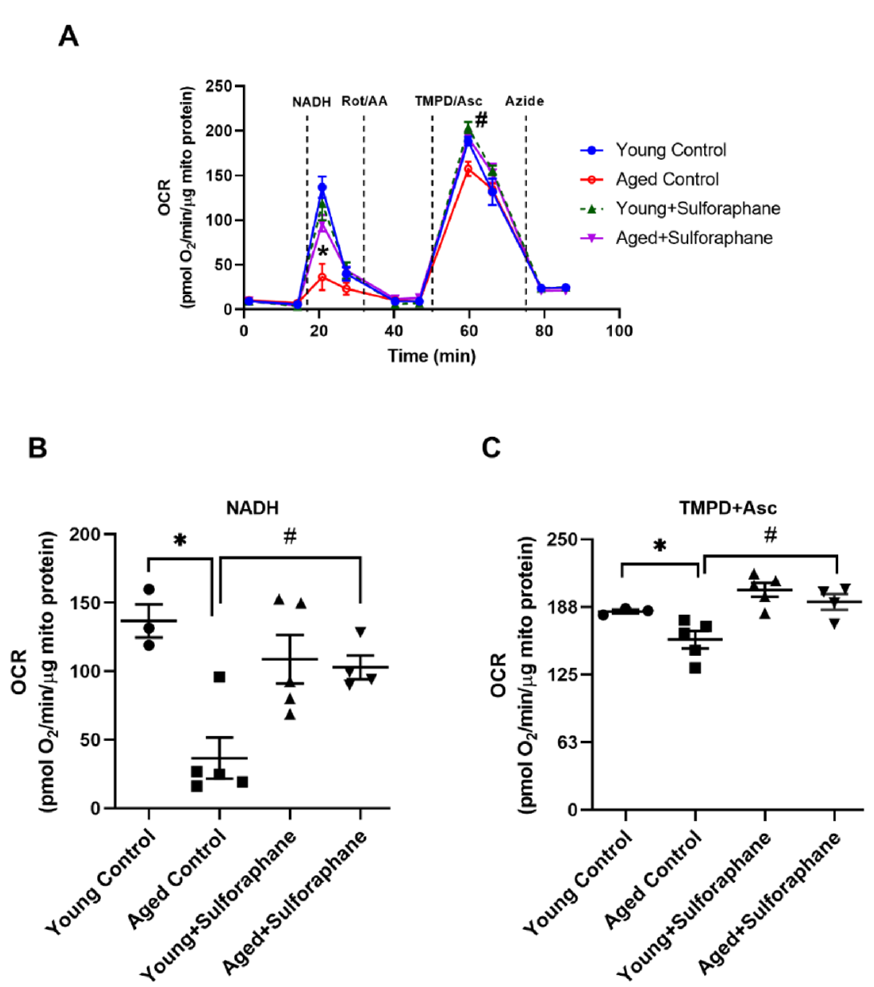
Figure 2. Sulforaphane improves age-mediated decrease in mitochondrial respiration. ( A ) Representative graph showing oxygen consumption rate by renal cortical mitochondria measured upon addition of electron donors specific for complex I (NADH), complex IV (TMPD+ascorbate), and inhibitors for complex I (Rot), complex III (AA), and complex IV (Azide). The vertical lines indicate the timepoint of addition of respective electron donors or inhibitors. ( B , C ) Bar graphs showing oxygen consumption rate measured using NADH and TMPD+ascorbate as electron donors, respectively, in the renal cortical mitochondria of young control (young F344 rats kept on tap water); aged control (aged F344 rats kept on tap water); young+sulforaphane (sulforaphane, 15 mg/kg body wt/day in drinking water); aged+sulforaphane. Results are presented as mean ± SEM, n = 3–5 rats. * p < 0.05 significantly different from young control rats; # p < 0.05 significantly different from aged control rats, using 1-way ANOVA followed by Newman–Keuls post-hoc test. Rot, rotenone; AA, antimycin A; TMPD, tetramethyl-p-phenylenediamine.